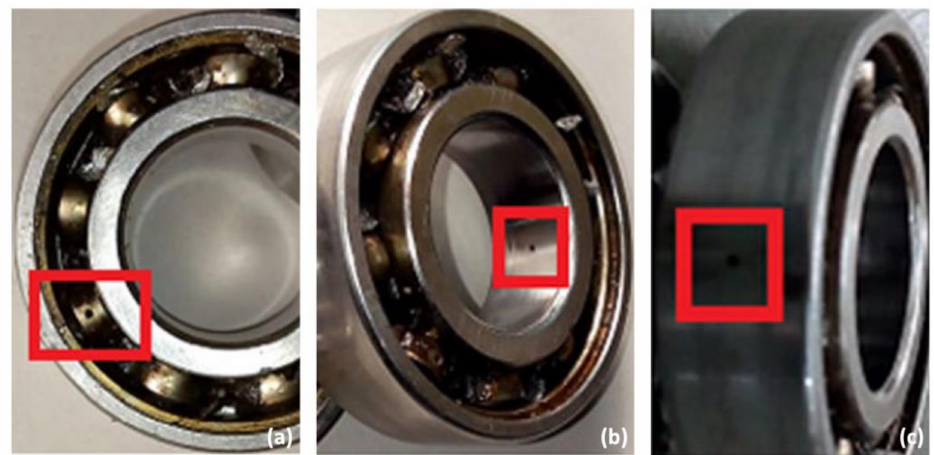
Figure 2. Defected bearings with different faults: ( a ) ball, ( b ) inner race, ( c ) outer race. [32].